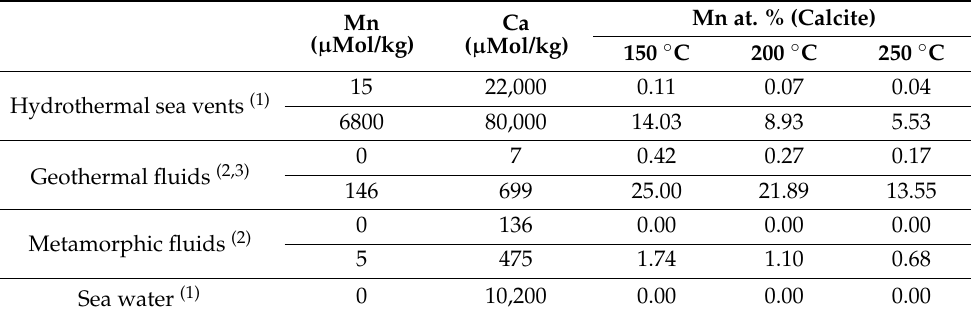
Table 2. Range of concentrations of Mn and Ca found in different types of